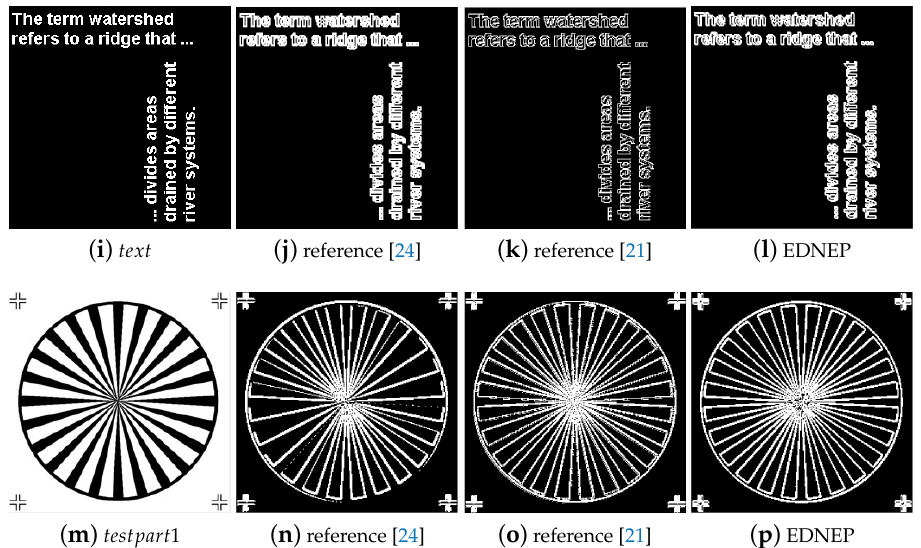
Figure 4. Edge detection results of images with less texture (the first column: the source gray images; the second to the last column: results by using methods in [21,24] and EDENP, respectively).